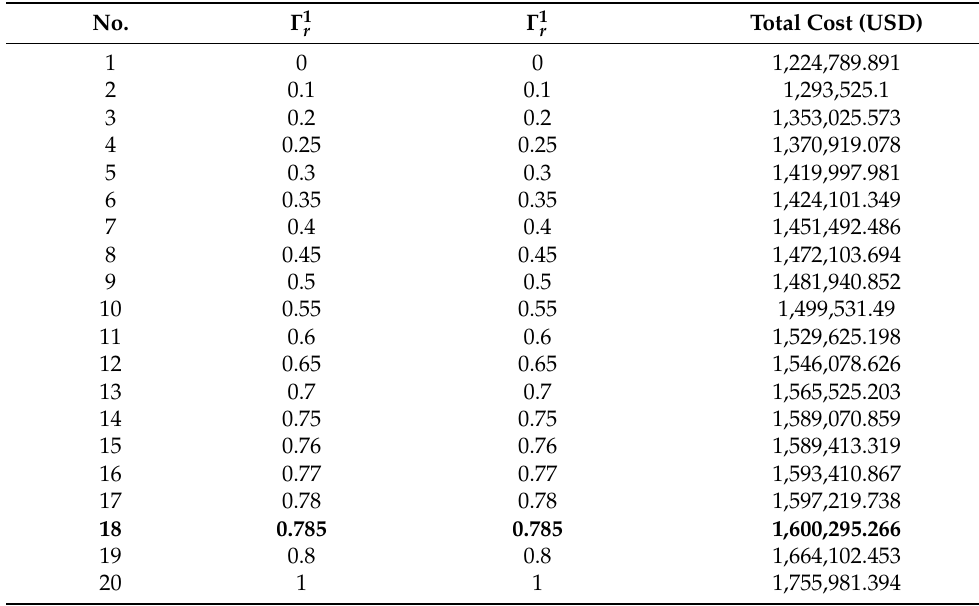
Table 11. Obtained results for determining TRW.